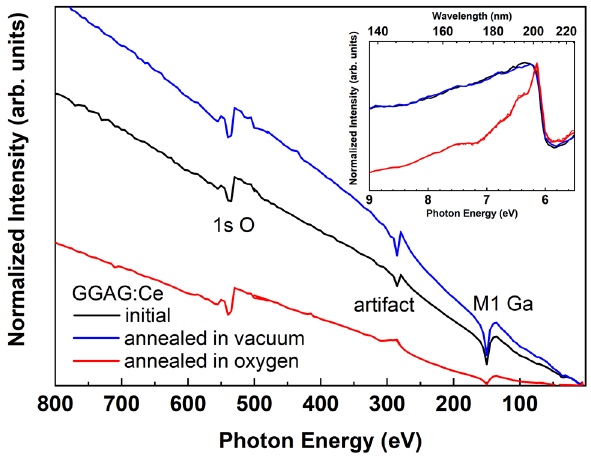
Figure 5. The low temperature excitation spectra of Ce 3+ emission (530 nm) in VUV-XUV spectral range for the annealed GGAG:Ce single crystals. All spectra are normalized to the excitonic